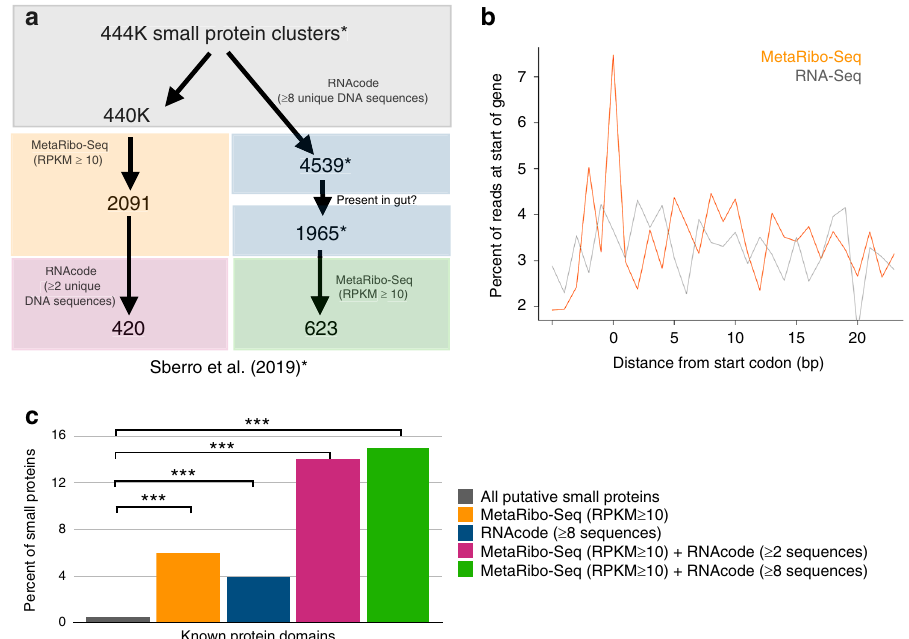
Fig. 5 Protein synthesis of small protein families in the gut microbiome. a Small gene families in HMPI-II metagenomes were identi fi ed, as performed previously 4 . Small proteins were predicted using MetaProdigal 42 after setting a 5 amino acid minimum for gene prediction. CD-Hit 55 clustered these small gene predictions across HMPI-II at 50% amino acid identity to create ~444,000 small gene clusters (see “ Methods ” ). With comparative genomics using RNAcode 25 , clusters with at least eight different sequences at a nucleotide level were further considered. ~4k small gene families were assigned signi fi cant p values with RNAcode 25 , suggesting coding potential. 1,965 of these small gene families were found in the fecal samples. 623 of these gene families are synthesized into proteins in the fecal samples. An additional 2,091 small protein families were predicted based on MetaRibo-Seq signal. Among these, 420 small protein families were supported by comparative genomics using RNAcode 25 , requiring at least two different sequences at a nucleotide level (see “ Methods ” ). b Signal distribution of RNA-Seq and MetaRibo-Seq reads at and directly 3 ′ of the start codon for all 2,091 predicted small gene families. c Percentage of known protein domains among groups of small protein families. We compare our higher con fi dence sets of small proteins to the ~444,000 putative small protein clusters using the hypergeometric distribution and fi nd that MetaRibo-Seq-predicted small proteins are signi fi cantly enriched for known protein domains compared to the initial, un fi ltered ~444,000 putative small protein predictions. Comparing these ~444,000 protein clusters to clusters supported by MetaRibo-Seq, RNA-code ( ≥ 8 sequences), MetaRibo-Seq + RNA-code ( ≥ 2 sequences), and MetaRibo-Seq + RNAcode (8 sequences), we calculate p values of 3.87 × 10 − 109 , 8.05× 10 − 90 , 8.07 × 10 − 65 , 5.38 × 10 − 104 , respectively. Signi fi cance was assigned as ***p value